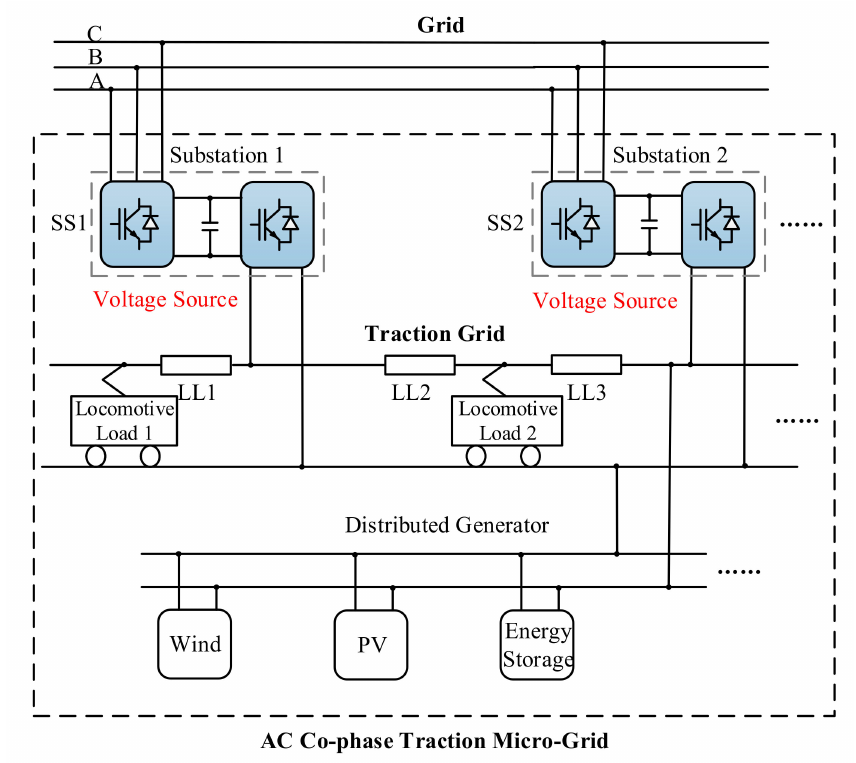
Figure 1. AC co-phase traction microgrid (PV: